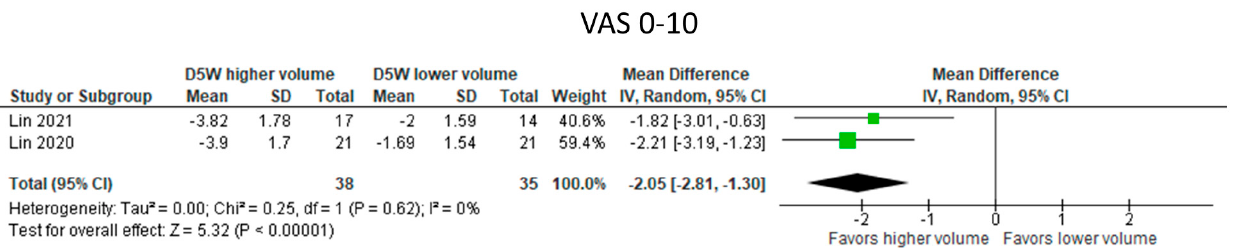
Figure 5. Meta—analysis of UPIT with higher volumes of D5W vs. lower volumes of D5W. VAS, visual analogue scale. The green squares represent the differences between the means of each of the two groups compared, i.e. the mean differences. The size of the green square represents how much that individual study affects the overall outcome of the meta—analysis, i.e. the weight of the studies